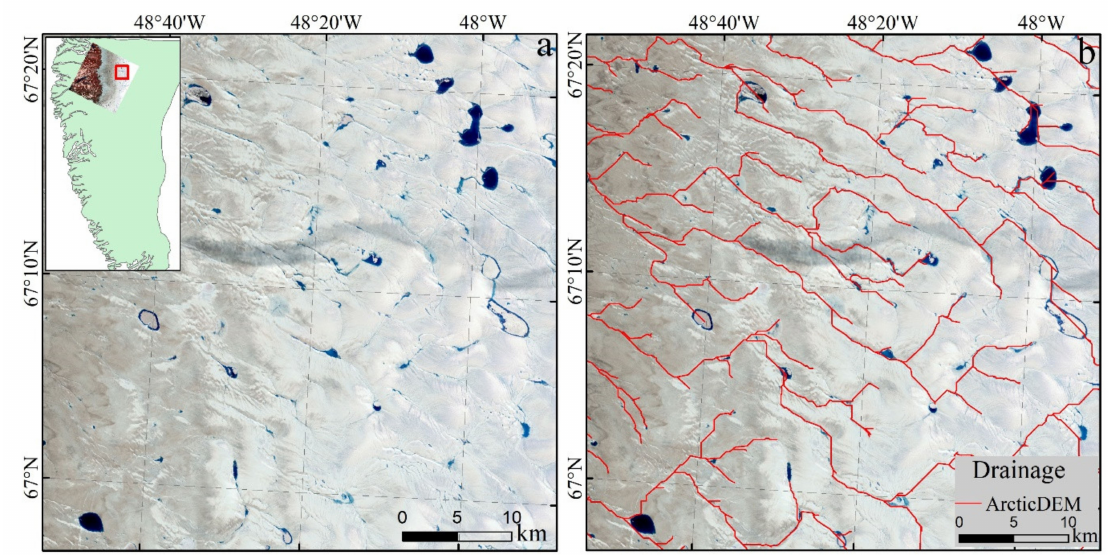
Figure 11. Verification of the ArcticDEM river network extraction result. The basin name of the inset map is the Southwest basin. Panel ( a ) is the distribution of the actual river network, and panel ( b ) is the river network extraction result for the ArcticDEM product. The background image is from Landsat-8 and was acquired on July 10,